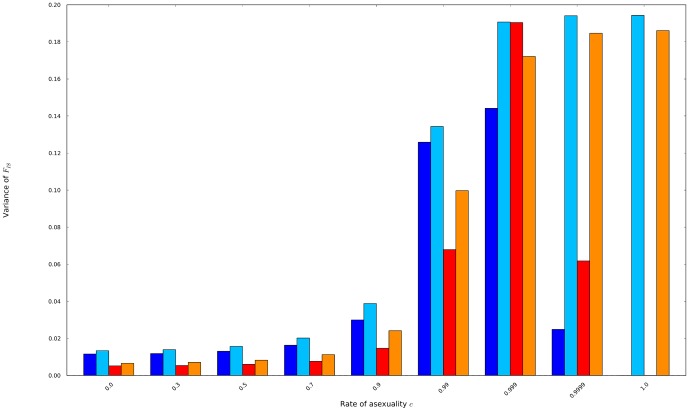
the variances of the possible distributions of F
IS were obtained from populations of 60 individuals mutating at a rate of 10−8 (dark blue) and 10−3 (light blue), and from populations of 140 individuals mutating at a rate of 10−8 (red) and 10−3 (orange).